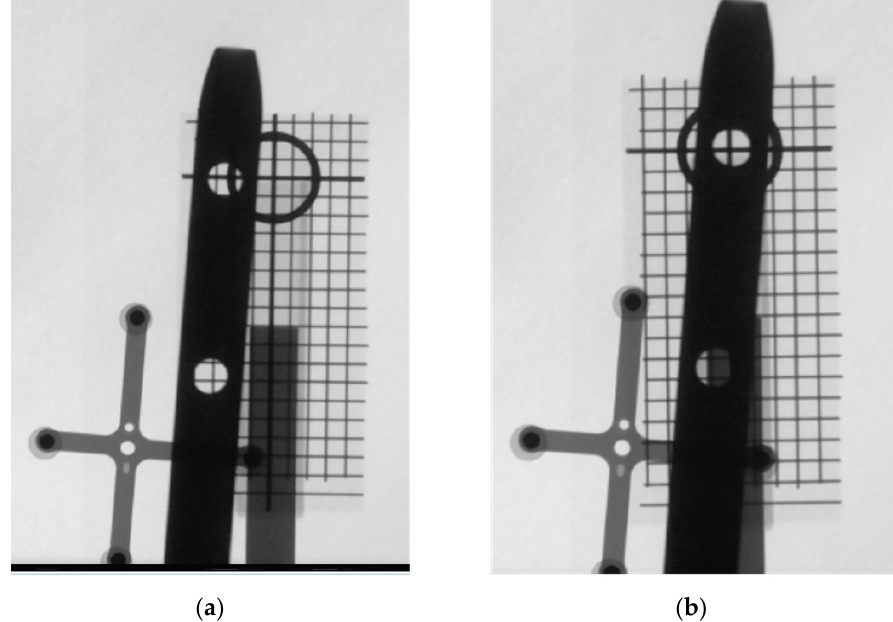
Figure 10. X-ray images before and after fine adjustment. ( a ) Misaligned state. ( b ) Aligned state.